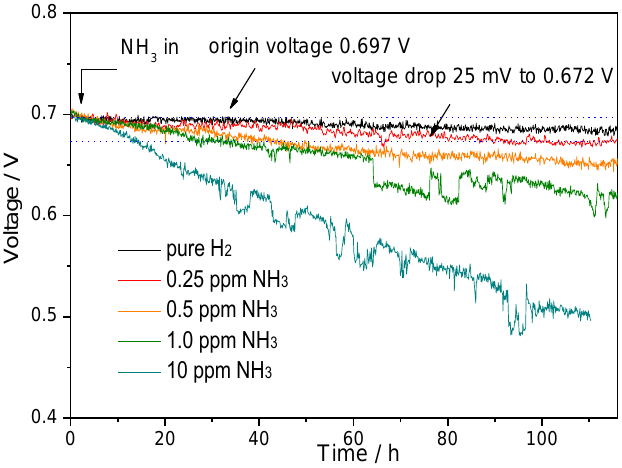
Figure 5. Performance changes of PEMFC after poisoning with NH 3 in fuel.